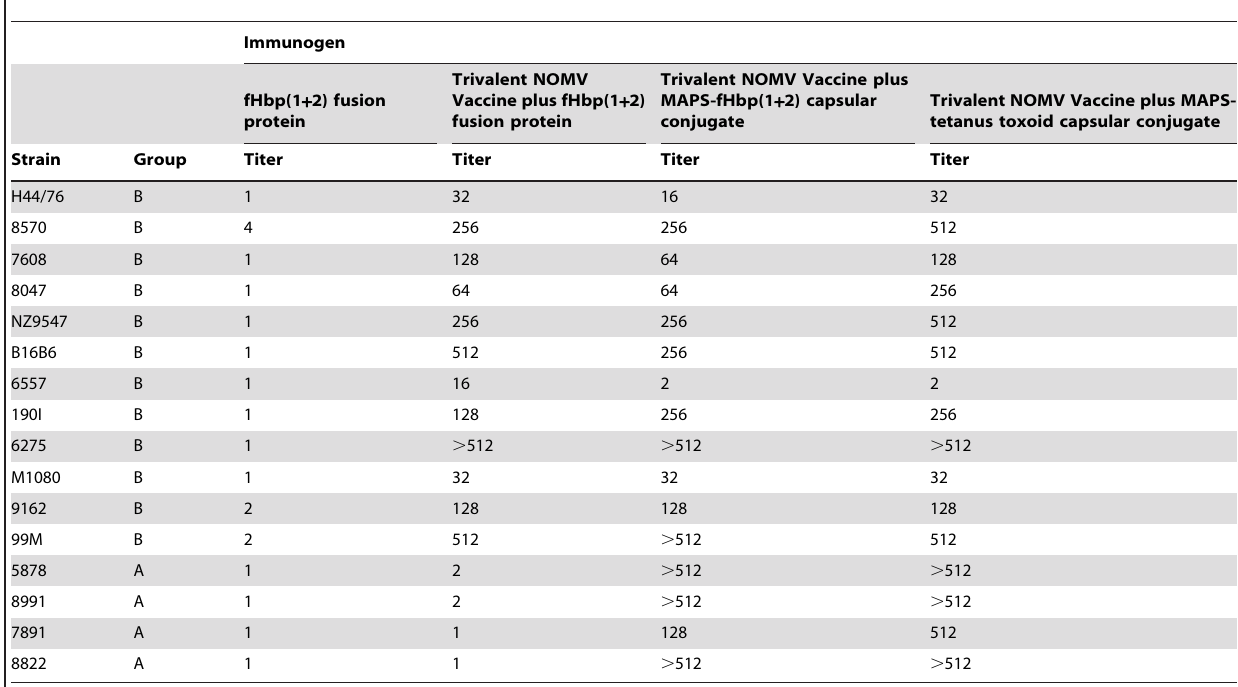
Table 4. Bactericidal activity of NOMV and either MAPS-fHbp(1 + 2) or MAPS-tetanus toxoid